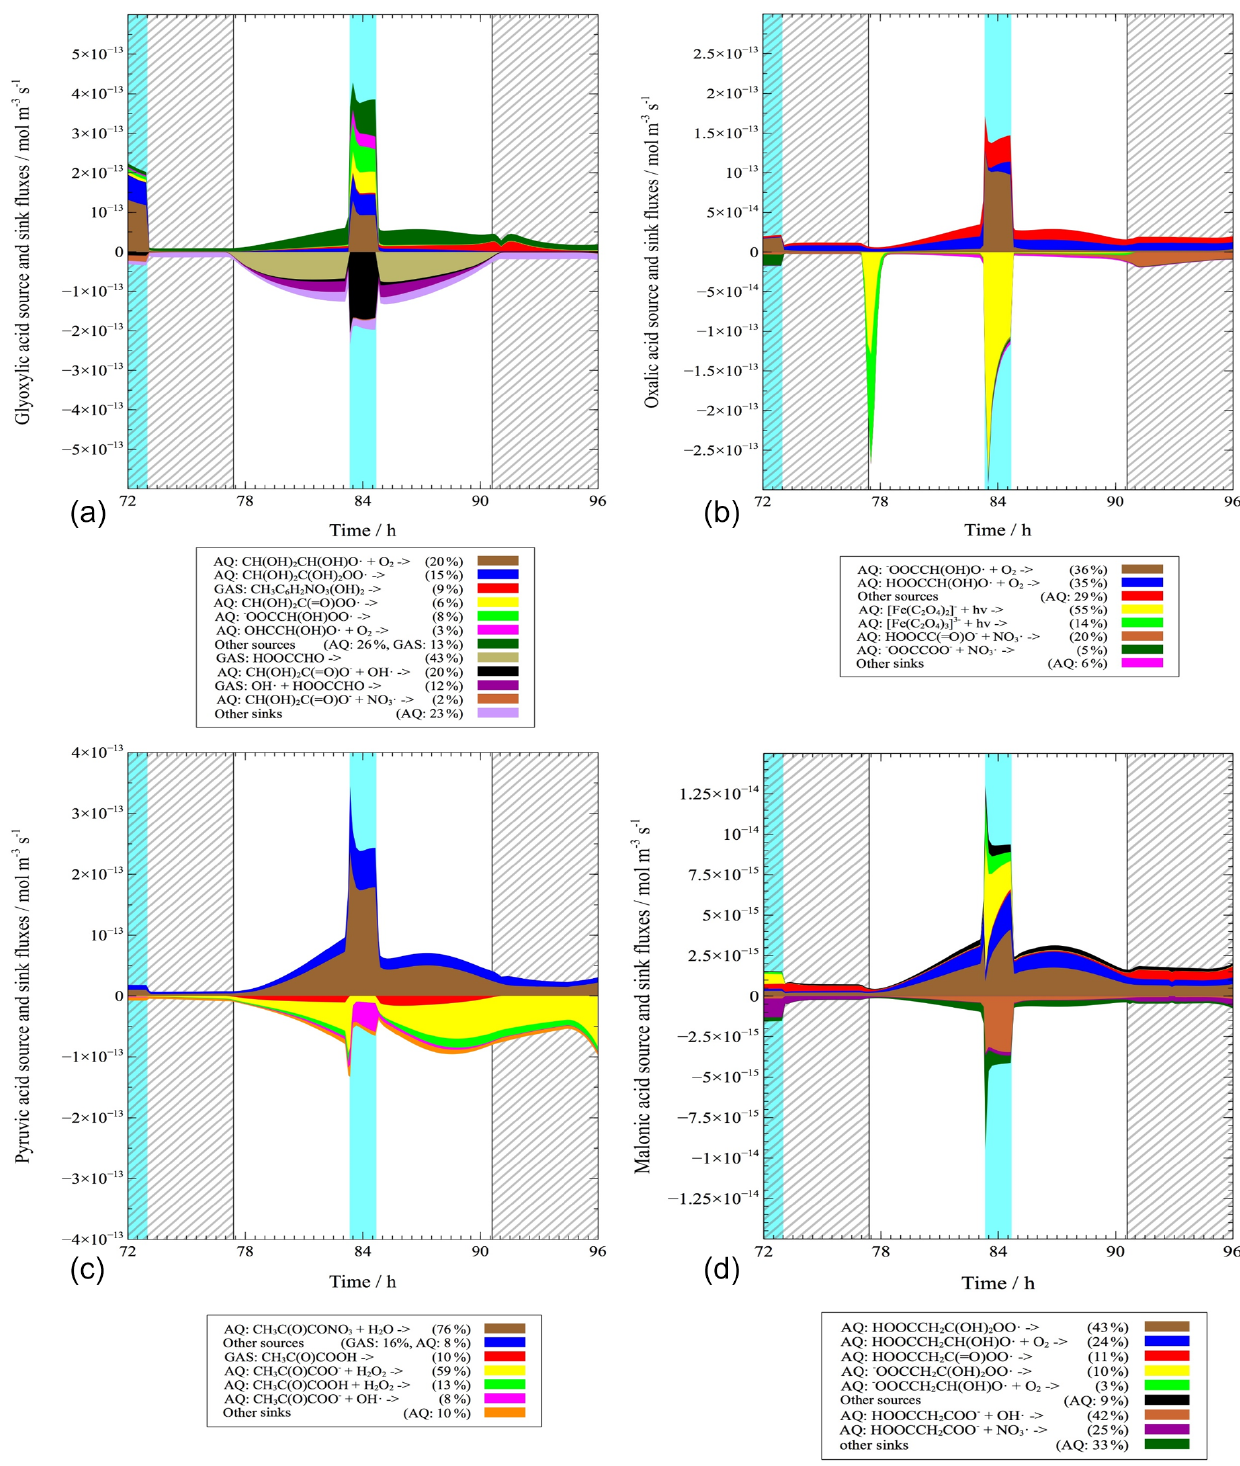
Figure 6. Modeled multiphase (gas phase + aqueous phase) source and sink fluxes of ω C 2 (a) , C 2 (b) , Pyr (c) and C 3 (d) along the trajectory of the third model day (light blue column: cloud; shadow: night). Percentage is given for the third model